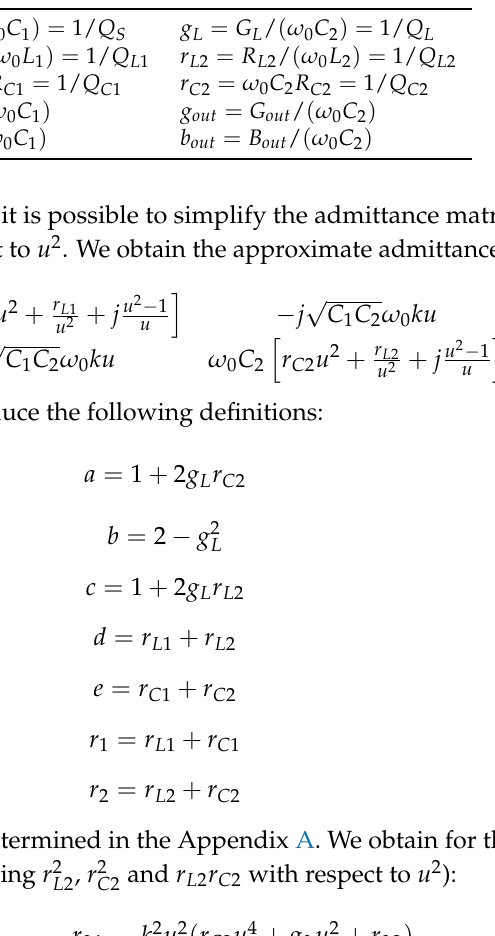
Table 1. Normalized quantities for